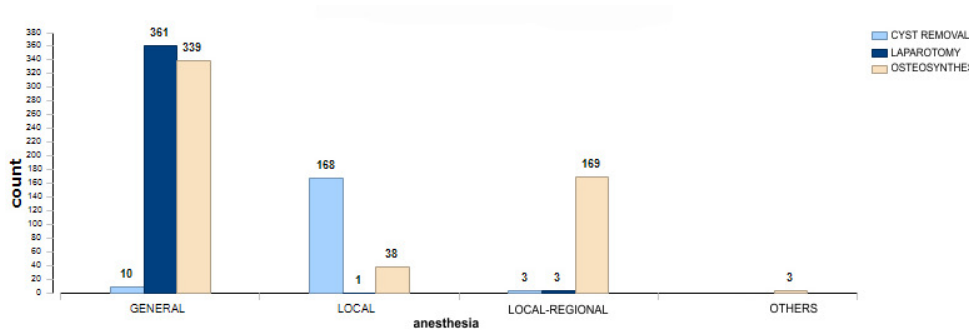
Figure 8: Datacube result for query C={(LAPAROTOMY),(REMOVAL, CYST)